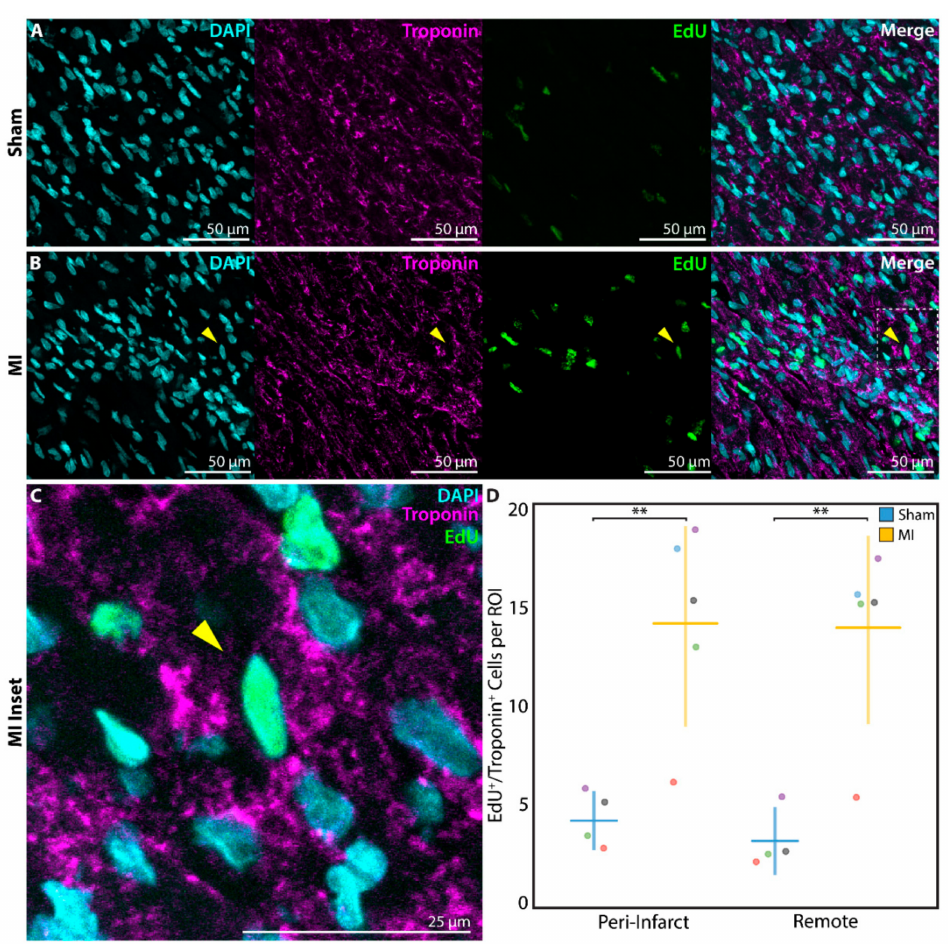
Figure 5. Assessment of cardiomyocyte proliferation using 5-ethynyl-2 (cid:48) -deoxyuridine (EdU) at 3 weeks after sham surgery ( n = 4) or induction of myocardial infarction (MI, n = 5) on postnatal day 1 (P1). EdU + / troponin + cardiomyocytes were detected within the peri-infarct region after ( A ) P1 sham and ( B ) P1 MI surgery. Inset ( C ) focuses on one EdU + / troponin + cardiomyocyte after P1 MI, marked by the yellow arrow. ( D ) Significantly more EdU + / troponin + cardiomyocytes were detected within each region of interest (ROI) for the P1 MI group compared to the P1 sham group in both the peri-infarct and remote regions. ** indicates p < 0.01. Horizontal lines indicate mean. Vertical lines indicate standard